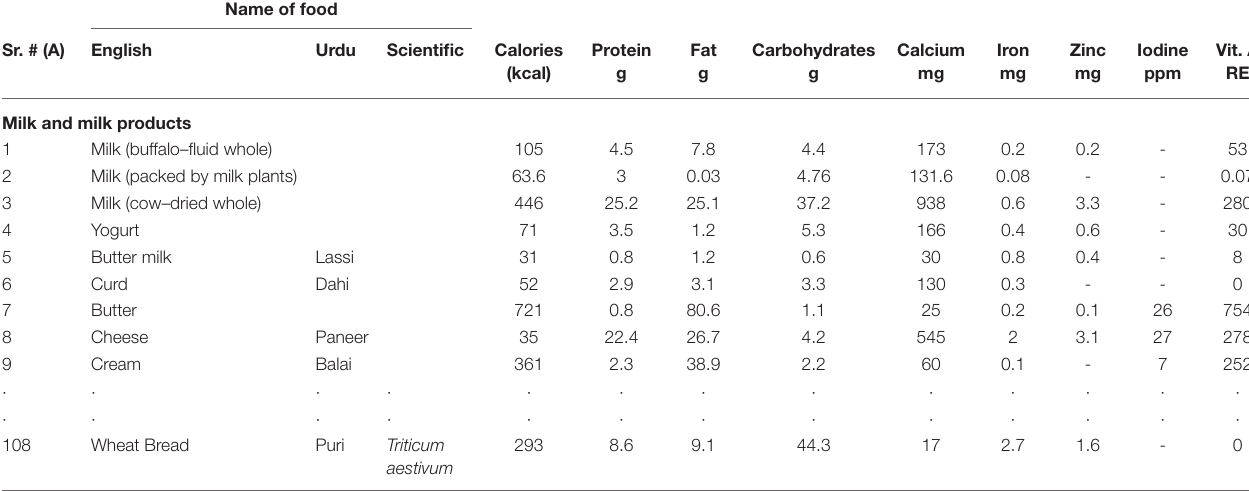
TABLE 1 | Food composition in Pakistan (100g of edible portion).